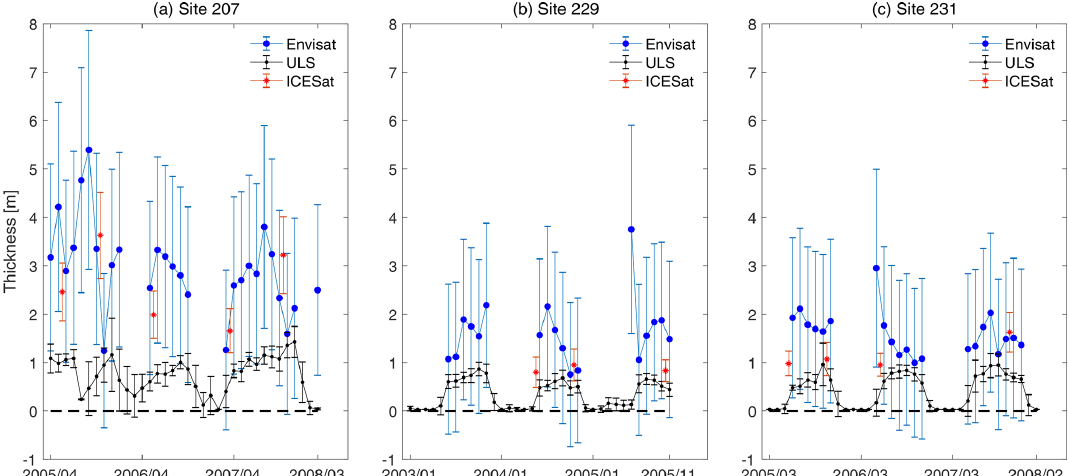
Figure 3. Time series of sea ice thickness and their uncertainties for the Weddell Sea ULS data, Envisat and ICESat. The numbers at the top represent the location of each site for the comparisons. The site locations can be found in Fig. 2. ICESat SIT values are placed between the 2 months that each period covers. Time is given in the format year/month. Table 4. Statistical results of the comparison between two satellite SIT products with ULS data. N is the number of comparison pairs. Site Env − ULS ICE − ULS N MD (m) SD (m) RMSD (m) MD (m) SD (m) RMSD (m) 207 1.63 0.67 0.60 1.73 0.70 0.62 5 229 0.72 0.61 0.43 0.42 0.07 0.05 2 231 1.11 0.41 0.33 0.55 0.29 0.24 3 Average 1.29 0.65 0.62 1.11 0.81 0.77